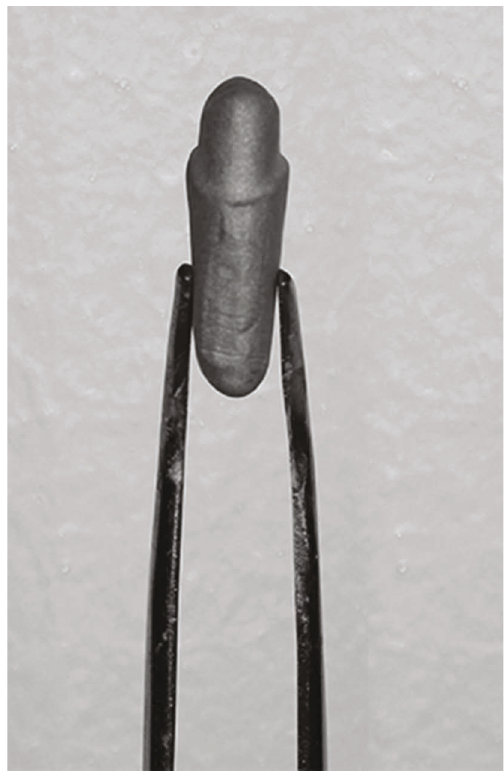
Figure 2: Metal analog of prepared right maxillary premolar.